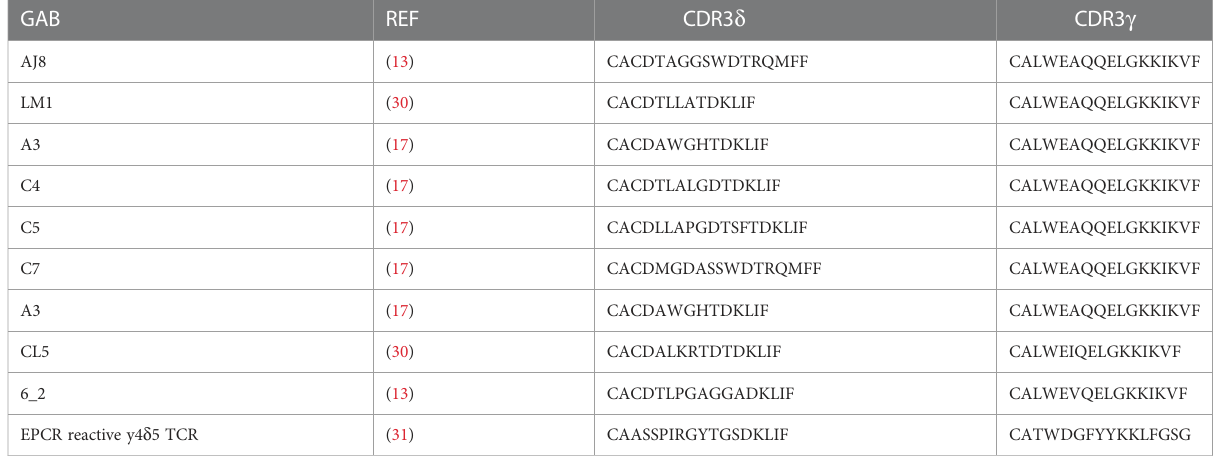
TABLE 1 GAB sequences. Depicted are sequences used for generation of y d ecto - a